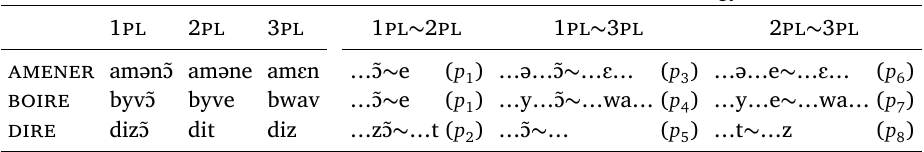
Table 8: Subparadigms and local patterns for three French verbs in the Indicative Present Plural